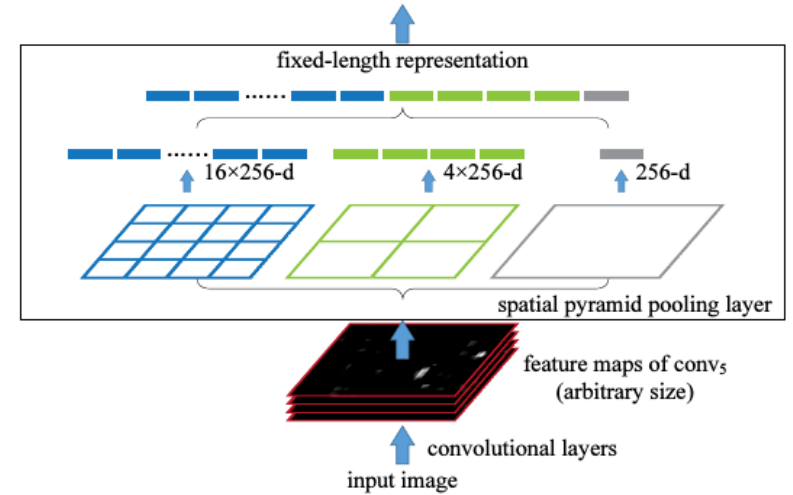
Figure 2. Principle of spatial pyramid pooling.